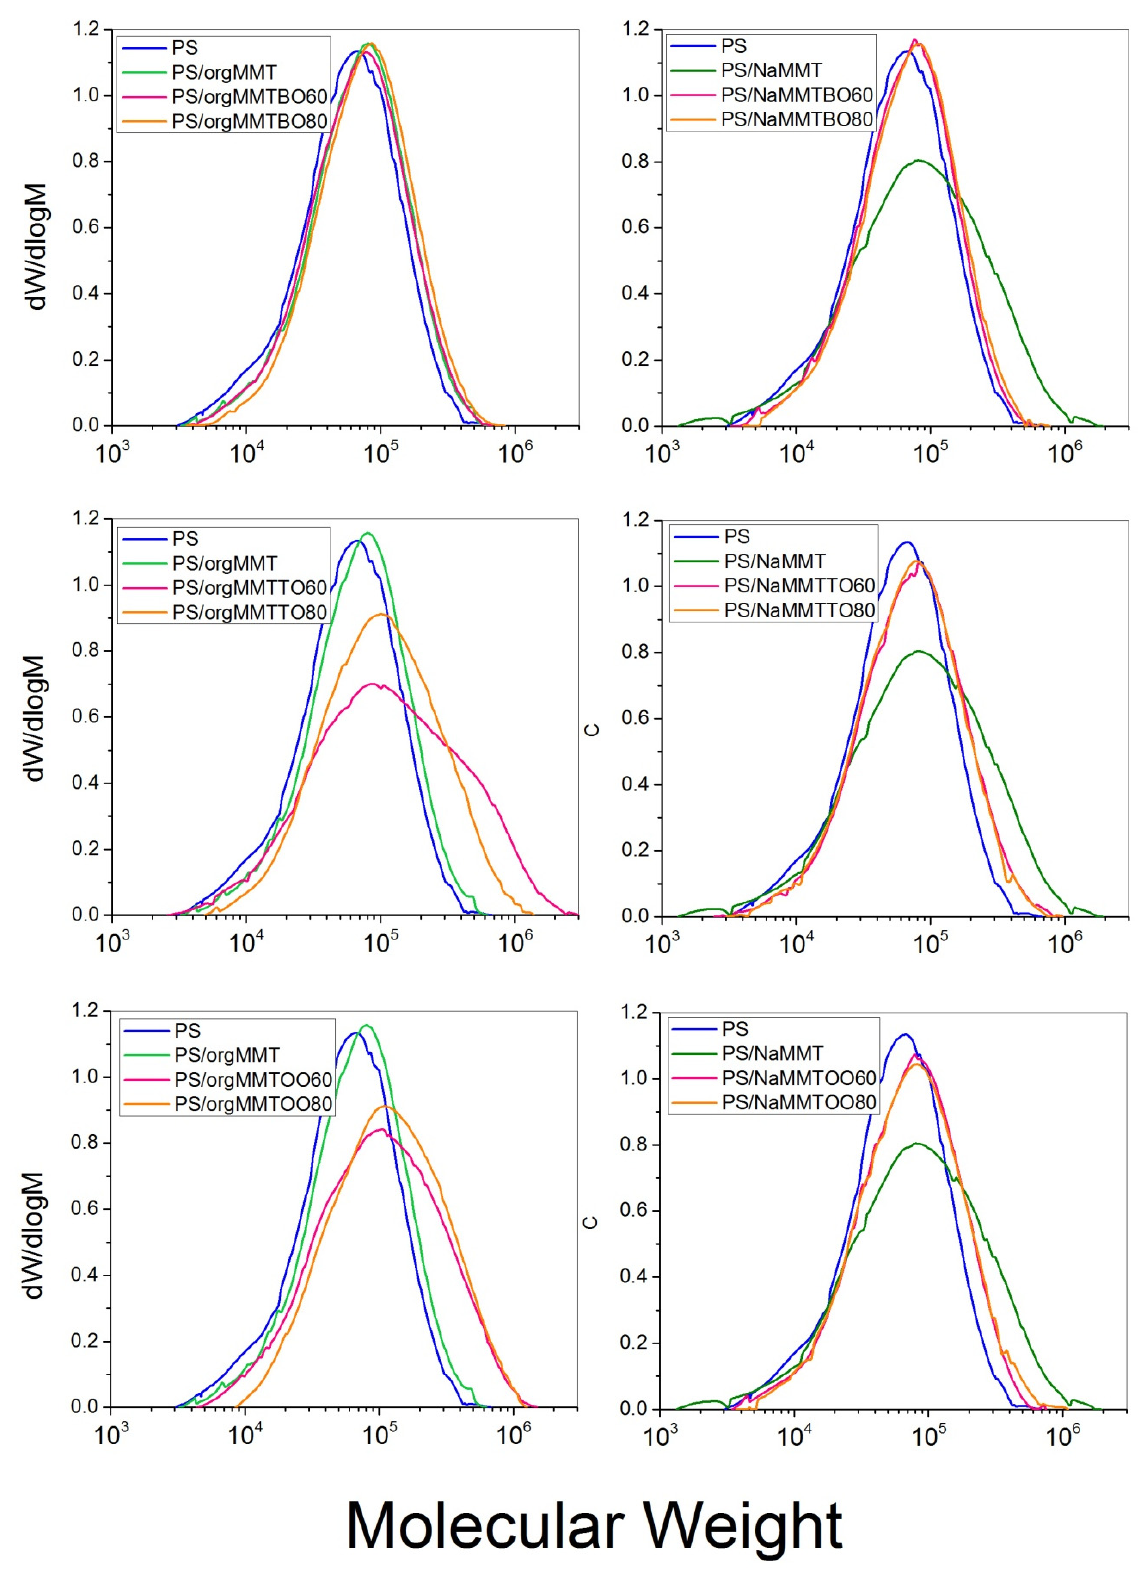
Figure 6. Molecular weight distribution of neat PS and its nanocomposites with either orgMMTBO, orgMMTTO, orgMMTOO (left column), or NaMMTBO, NaMMTOO and NaMMTTO (right column).